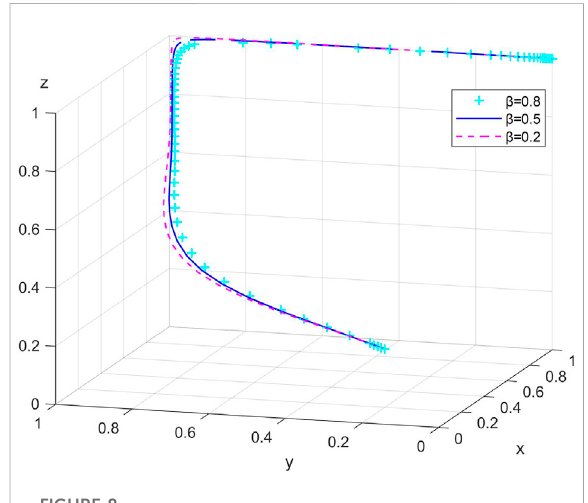
FIGURE 8 Impactofgovernmentregulationontheintensityofbusiness.